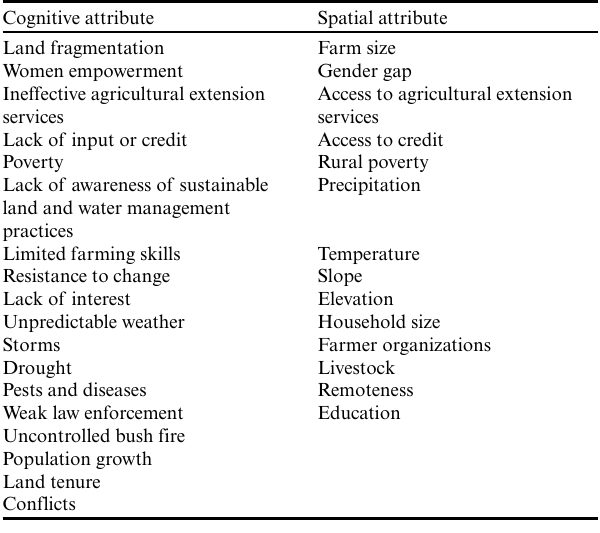
Table 1. Lists of cognitive and spatial attributes. The first five lines contain the cognitive and spatial attributes used in the uncertainty analysis because of their direct